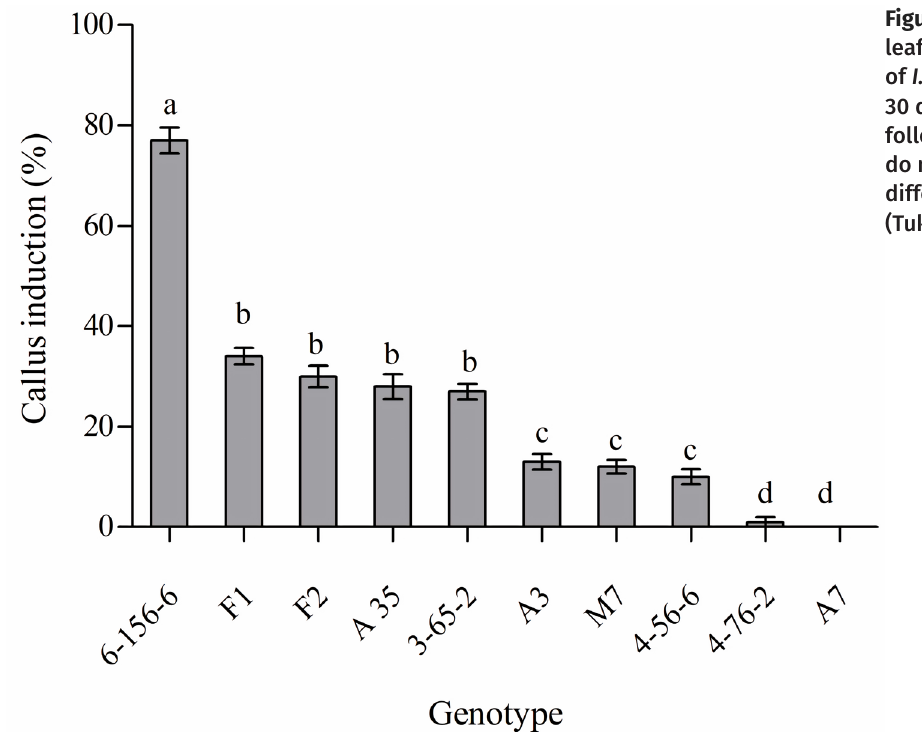
Figure 1. Callus induction on leaf explants of 10 clones of I. paraguariensis after 30 days on culture. Bars followed by the same